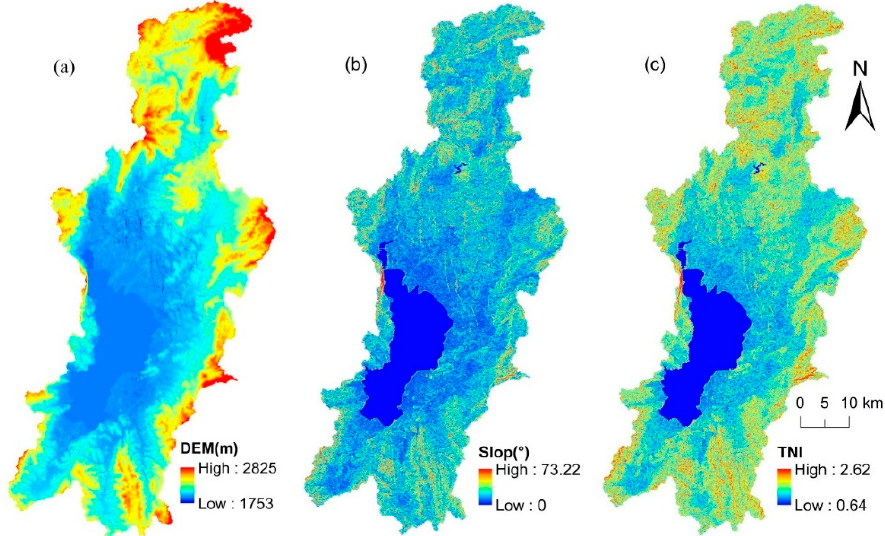
Figure 2. DEM ( a ), Slope ( b ), and TNI ( c ) of the Dianchi Lake basin, China.